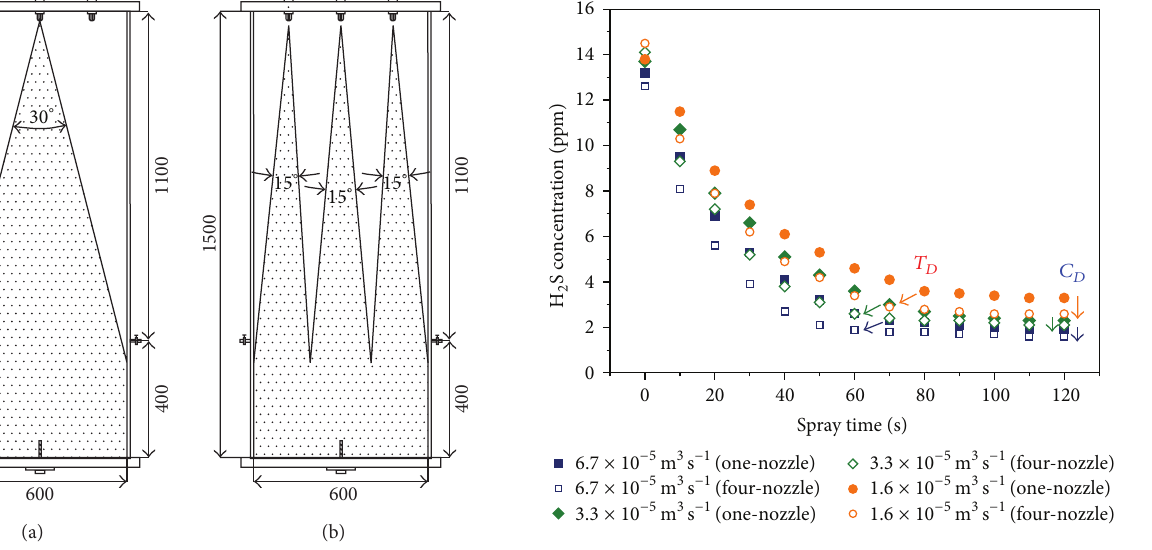
Figure 5: Schematics of the modified spray tower, using four-nozzle set versus one-nozzle set.